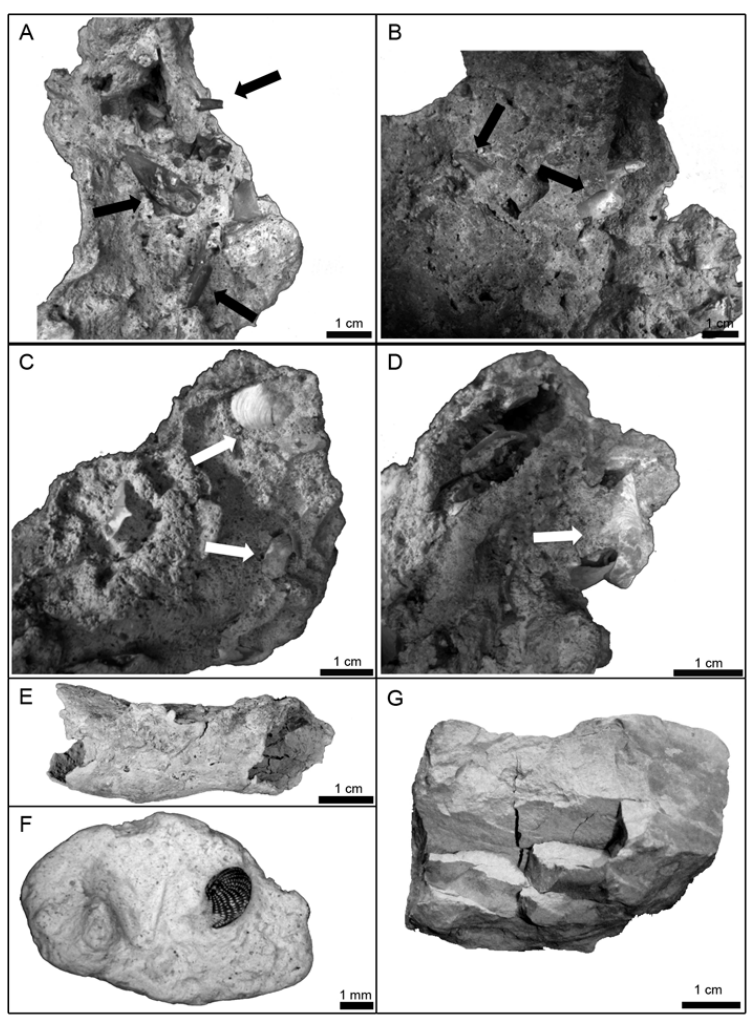
Fig. 9. Carbonates from the GBPF: (A–D) authigenic concretions (cemented matrix) embedding skeletal biosomes of seep-related metazoans, all from st. MEDCOR78: (A–B) Calliax , (C–D) Isorropodon ; (E) indurated callianassid? burrow, armoured with chemosymbiotic-organisms bioclasts; (F) cemented matrix embedding a reworked black-stained shallow-water foraminifer ( Elphidium crispum ); (G) cemented mudstone layer at 210–230cm in core MEDCOR70.